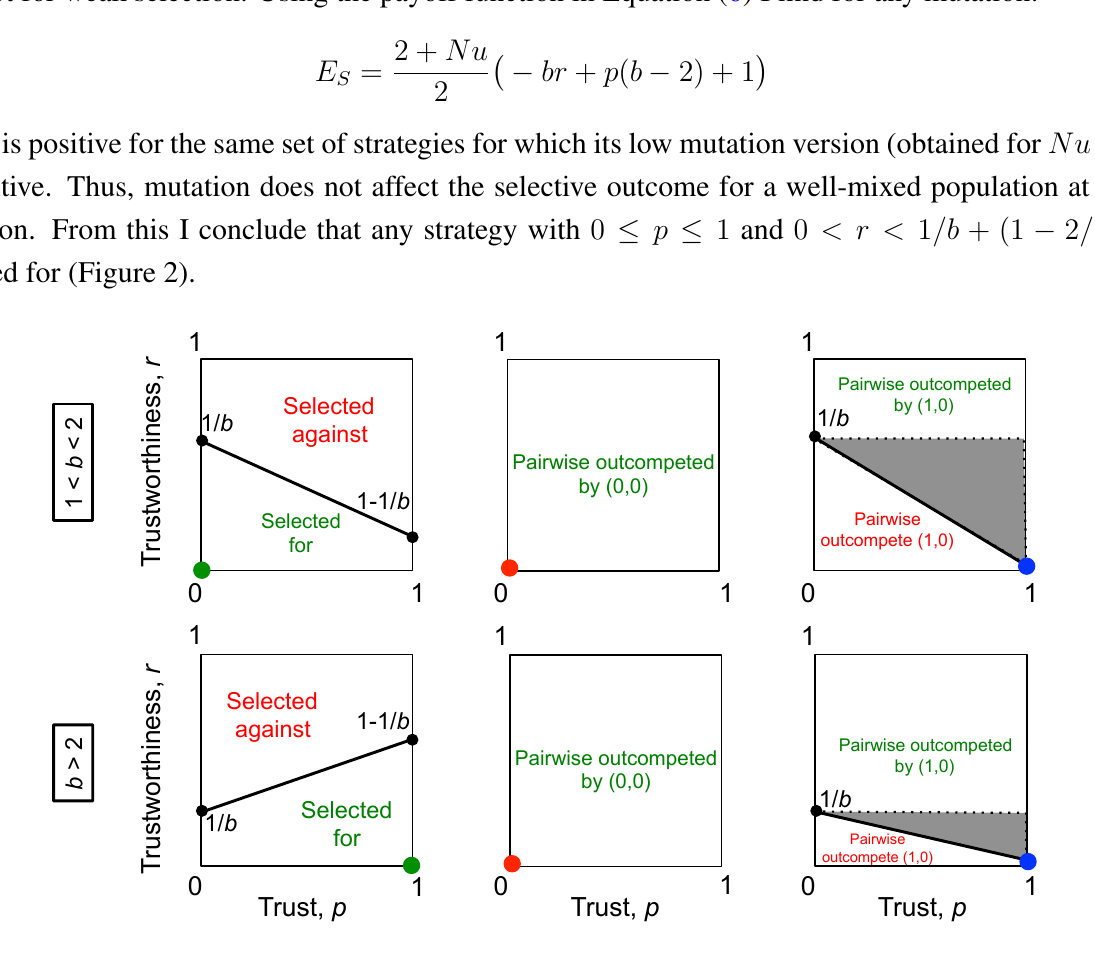
Figure 2. In a well-mixed population, in the limit of weak selection, both trust and trustworthiness are selected for and, for sufficient returns, the trusting but not trustworthy strategy, (1 , 0) , is the optimal strategy. Upper panels: 1 < b < 2 . Left: the most abundant strategy (green dot) is (0 , 0) – no trust and no trustworthiness. However, strategies with any amount of trust but low trustworthiness are also selected for, albeit less abundant. Middle: strategy (0 , 0) outcompetes all other strategies. Right: strategy (1 , 0) (blue dot) outcompetes a large number of strategies in pairwise interactions; for a subset of these strategies, (1 , 0) wins more in pairwise interactions than does (0 , 0) (grey shaded area). Lower panels: b > 2 . Left: the most abundant strategy (green dot) is (1 , 0) – complete trust and no trustworthiness. However, strategies with any amount of trust and significant levels of trustworthiness are also selected for, albeit less abundant. Middle: strategy (0 , 0) outcompetes all other strategies. Right: strategy (1 , 0) (blue dot) outcompetes a large number of strategies in pairwise interactions; for a subset of these strategies, (1 , 0) wins more in pairwise interactions than does (0 , 0) (grey shaded area).